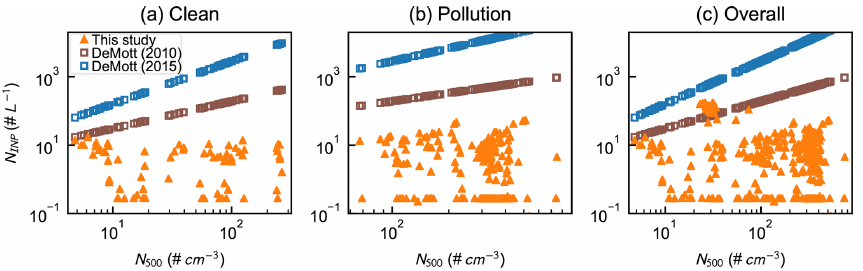
Figure C3. Intercomparison of measured (solid orange triangles) and predicted (hollow blue and brown squares) N INP on clean (a) and heavy pollution (b) days, as well as during the observation (c) . The prediction is based on the parameterizations that link N INP with the number concentration of particles larger than 500nm ( N 500 ) at a specific temperature (DeMott et al., 2010, 2015).